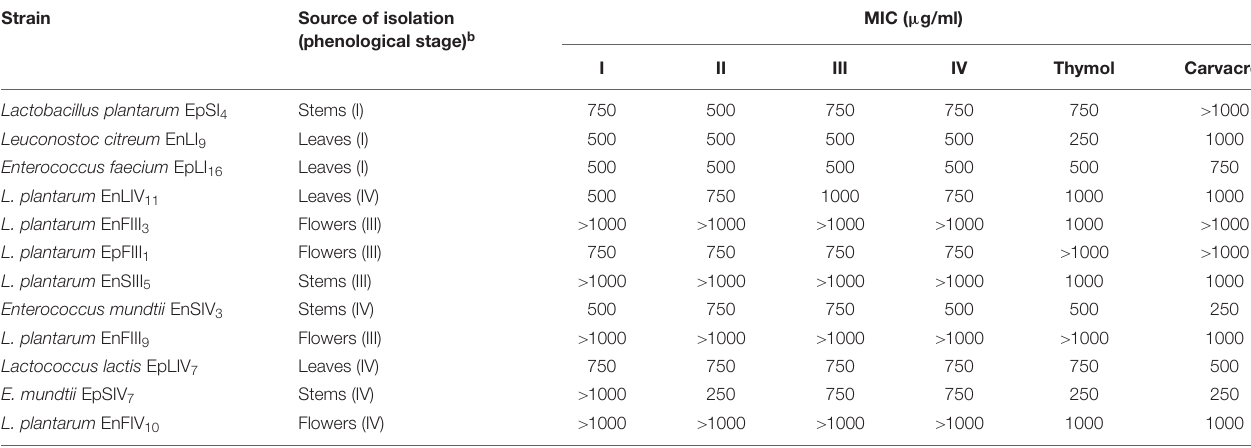
TABLE 2 | Antimicrobial activities a of essential oils extracted from the whole plant of Origanum vulgare L. at the early vegetative (I), late vegetative (II), blooming (III), and full flowering (IV) stages, thymol and carvacrol toward lactic acid bacterial strains. Strain Source of isolation (phenological stage)